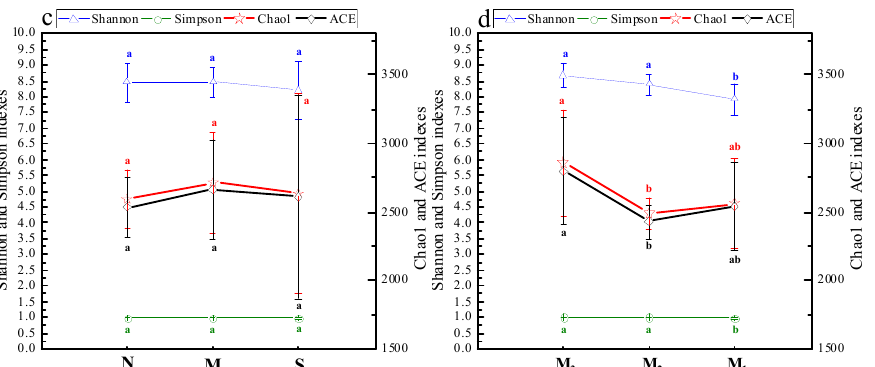
Figure 5. Shannon, Simpson, Chao1, and ACE indices of bacterial communities in the rhizosphere of Chinese fir provenances. Indices changed with latitude ( a ), longitude ( b ), and different blocks ( c , d ). For every provenance with three replicates, one-way variance analysis with the least significant difference test ( p < 0.05) was performed using SPSS Statistics 19.0. Letters display the significant shift amongst provenances or blocks. N, northern belt; M1, western middle belt; M2, central middle belt; M3, eastern middle belt; S, southern belt.